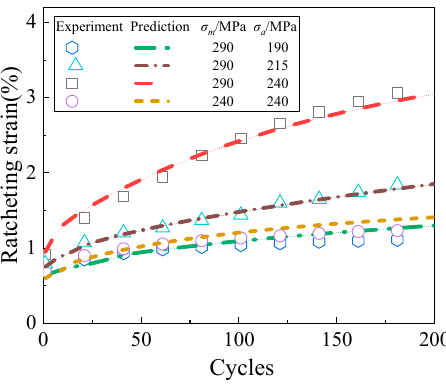
Figure 10. The ratcheting strain under different working conditions by the proposed model.